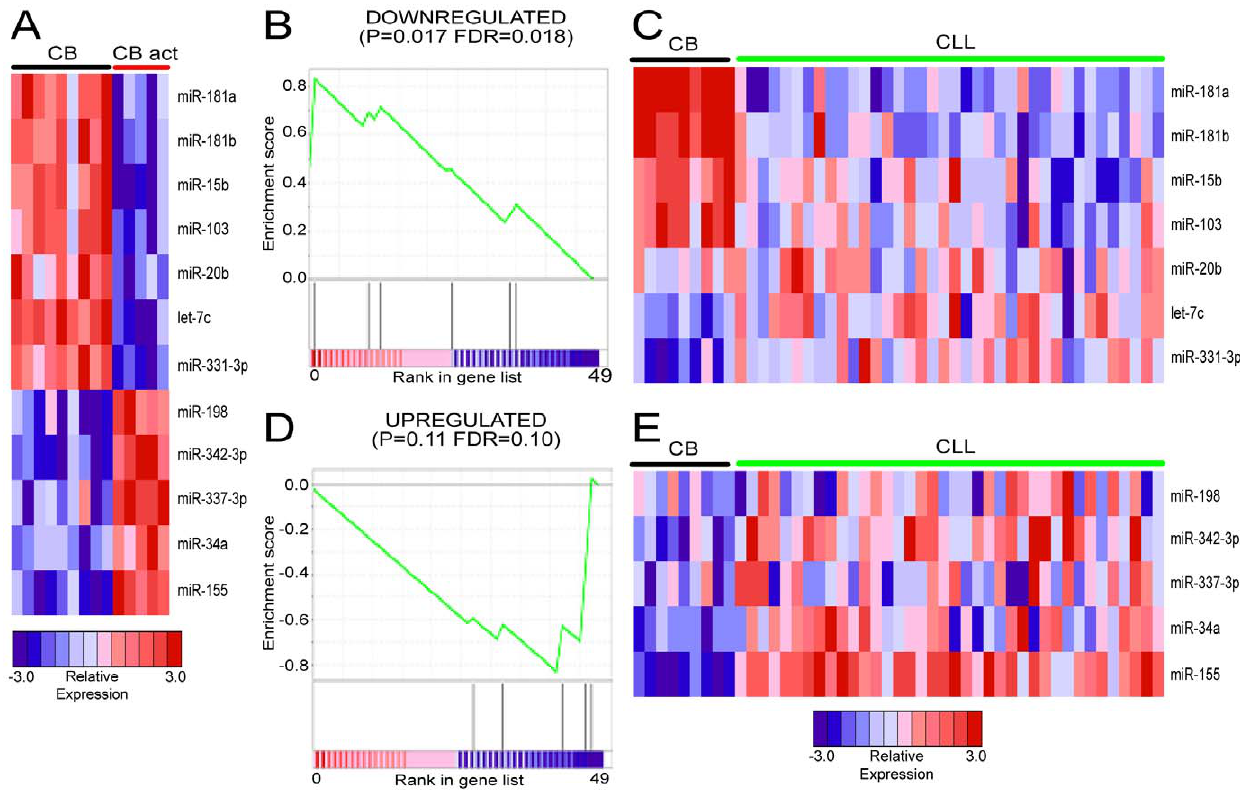
Figure 1. GSEA reveals a B cell activation miRNA signature in CLL. A. Heatmap of B cell activation signature miRNAs comparing expression in unstimulated control B (CB) cells and CpG activated B cells (CB act). B. GSEA enrichment profile of downregulated B cell activation signature miRNAs in control B cells versus CLL cells. C. Heatmap of downregulated B cell activation signature miRNA expression in control B cells and CLL cells. D. GSEA enrichment profile of upregulated B cell activation signature miRNAs in control B cells versus CLL cells. E. Heatmap of upregulated B cell activation signature miRNA expression in control B cells and CLL cells.